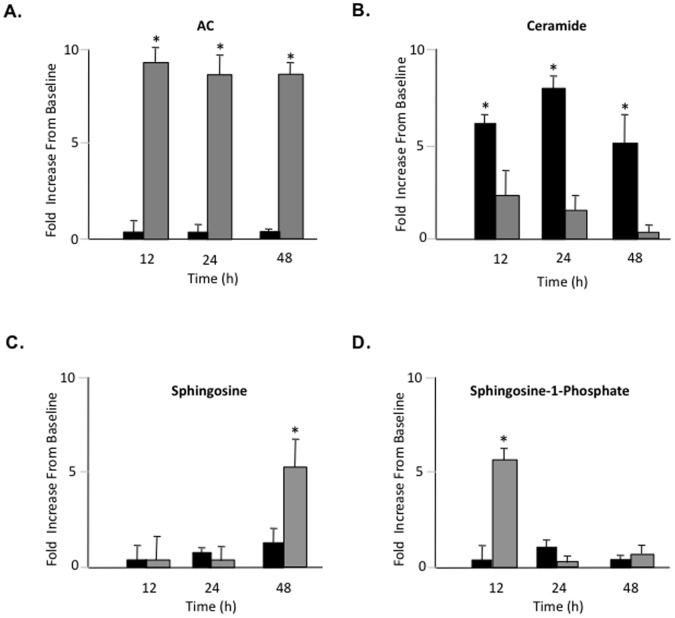
Primary rat articular chondrocytes were isolated and grown in monolayer cultures for 48 h with or without rAC (rAC, 200 U/ml) added to the media.At the indicated times proteins and lipids were extracted from the cells, and A) AC activity, B) ceramide, C) sphingosine, and D) sphingosine-1-phosphate levels were determined. Note that the addition of rAC to the culture media (gray bars) led to markedly increased AC activity in the cells by 12 h that was sustained for at least 48 h. In addition, by 12 h ceramide levels were elevated compared to baseline, but significantly less so in cells treated with rAC (i.e., by 48 h cells treated with rAC had no detectable ceramide elevation). Finally, the levels of S1P and sphingosine were elevated in rAC-treated cells by 12 and 48 h, respectively. * = p<0.05.